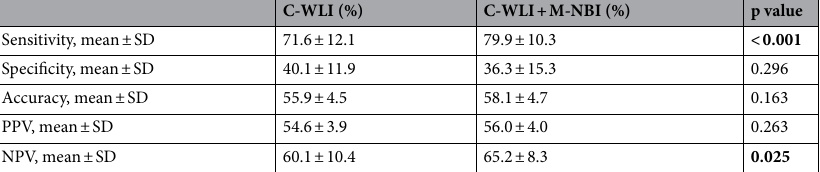
Table 3. Diagnostic rate of C-WLI and C-WLI + M-NBI. Significant values are in bold. Sensitivity, specificity, accuracy, PPV, NPV represent the mean ± SD of 14